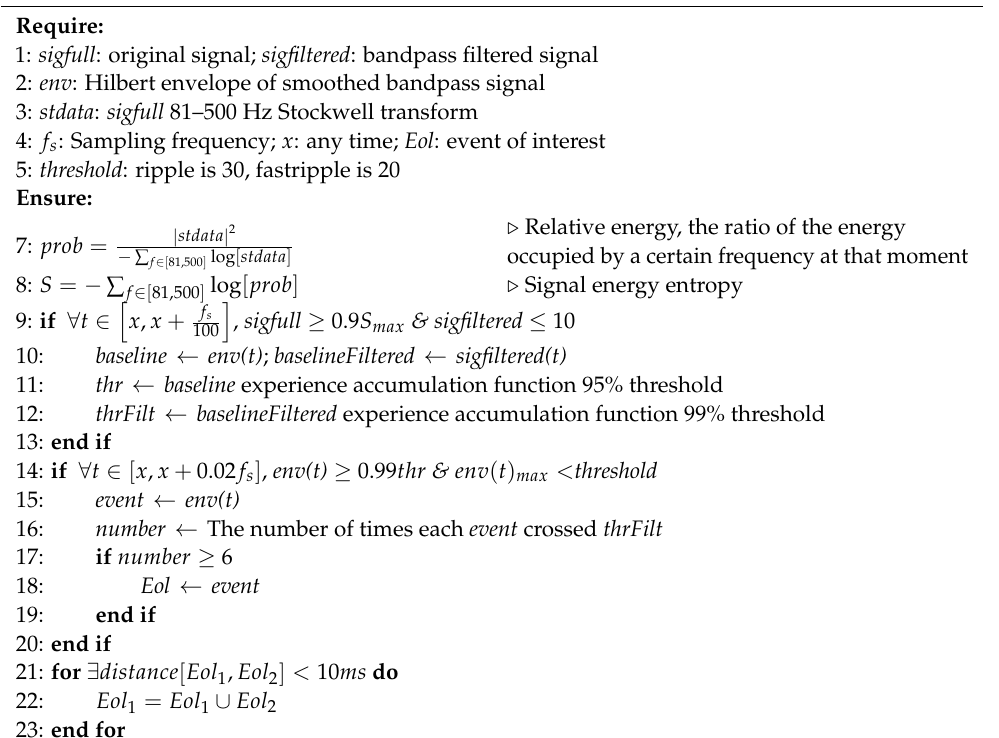
Algorithm 1: Preliminary Screening